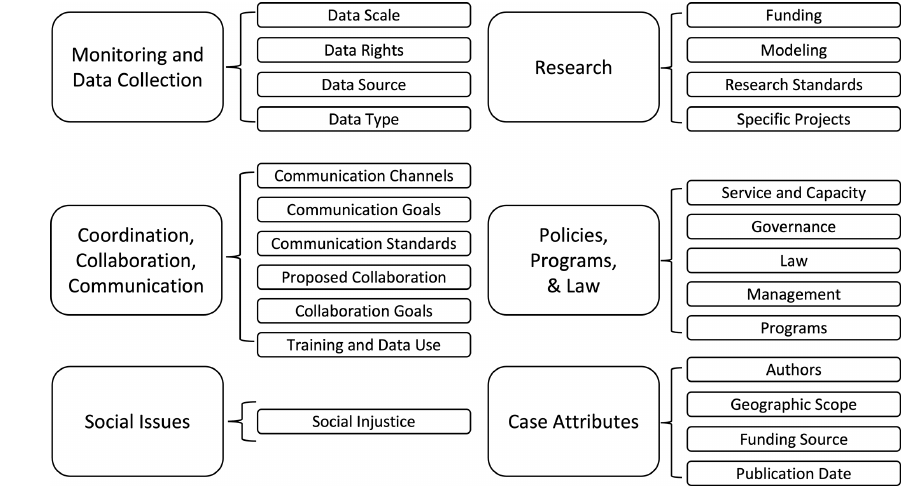
Figure 2. The main nodes and associated sub-nodes of the coding schema. The order of nodes or sub-nodes does not suggest